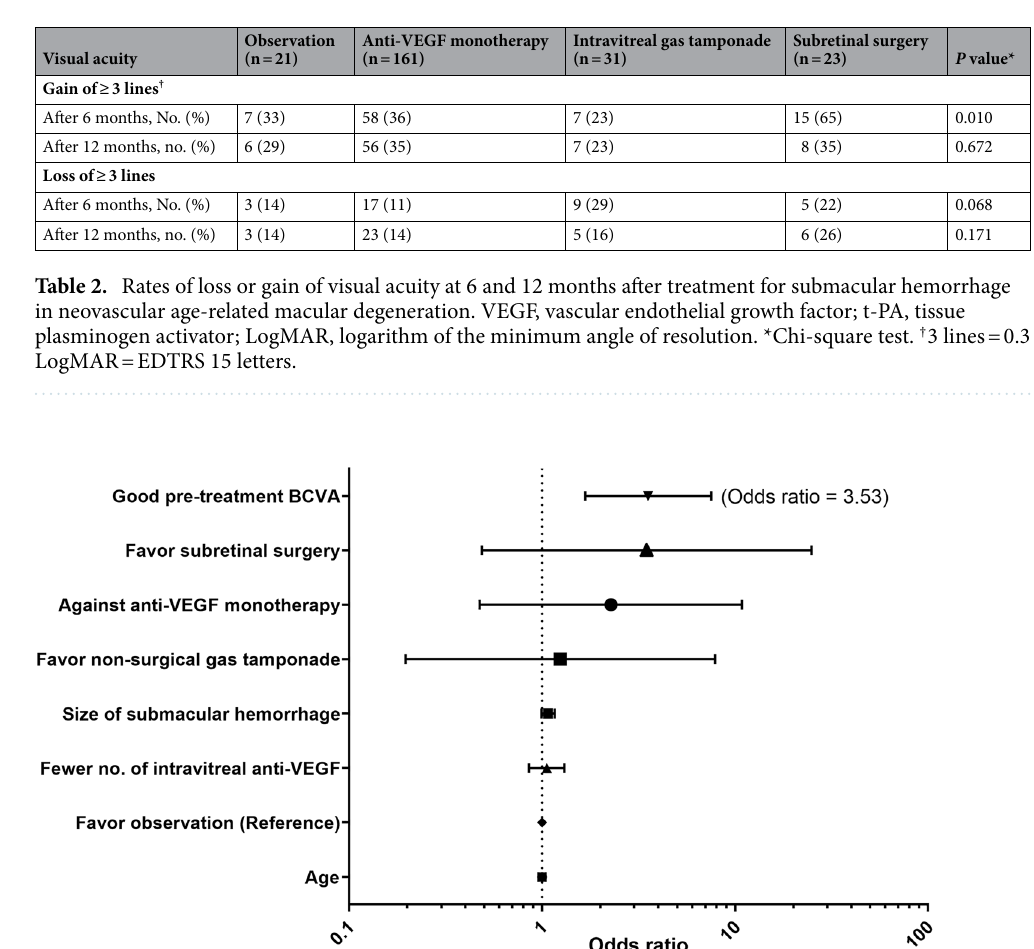
Figure 4. Rate of loss or gain of visual acuity. ( A ) Gain of ≥ 3 lines ( B ) Loss of ≥ 3 lines. VEGF, vascular endothelial growth factor.